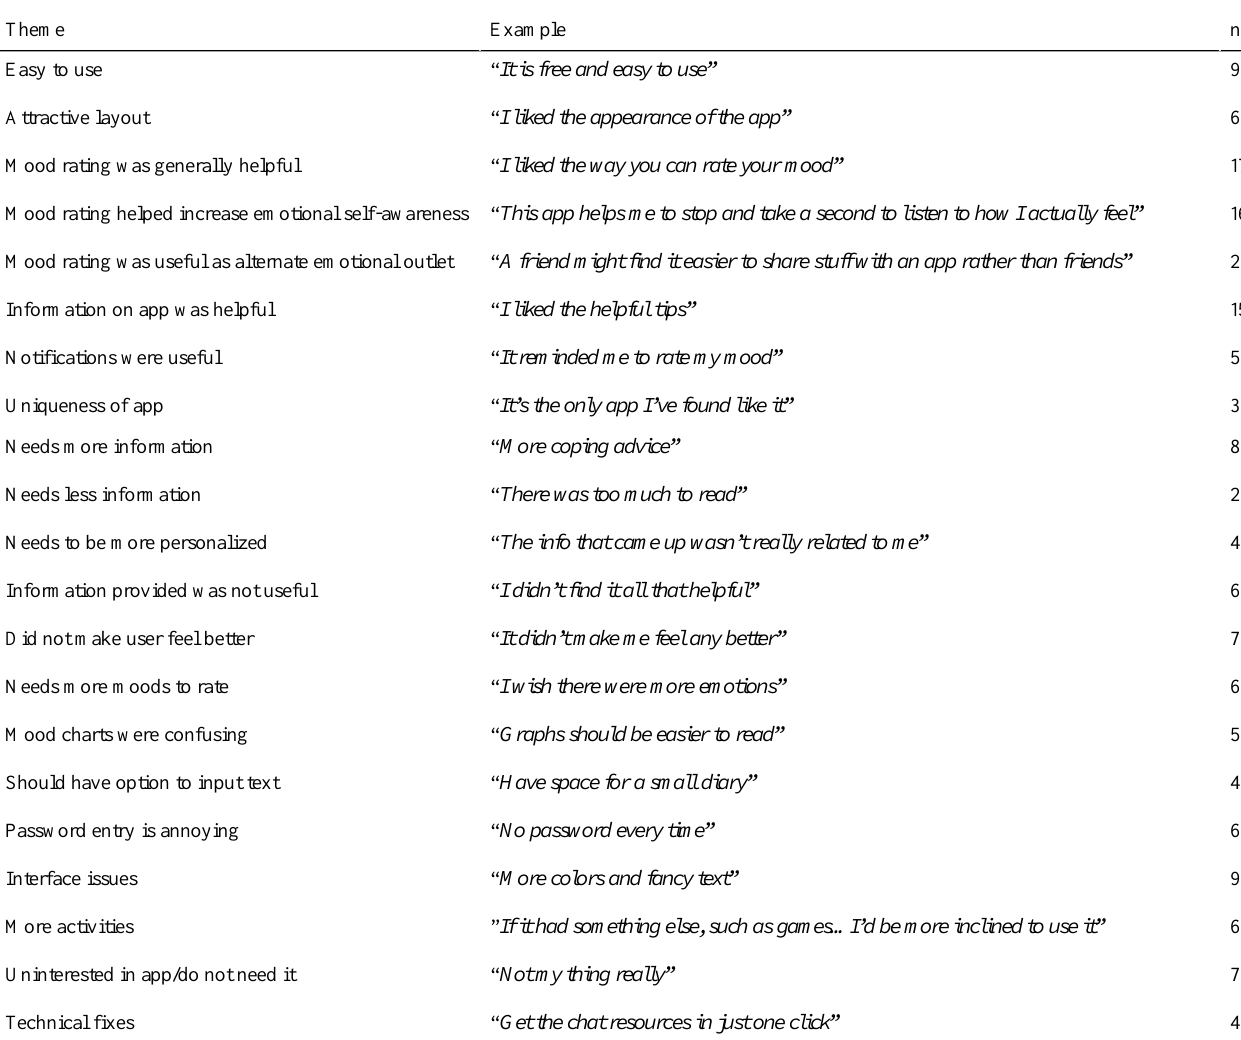
Table 2. Qualitative feedback from